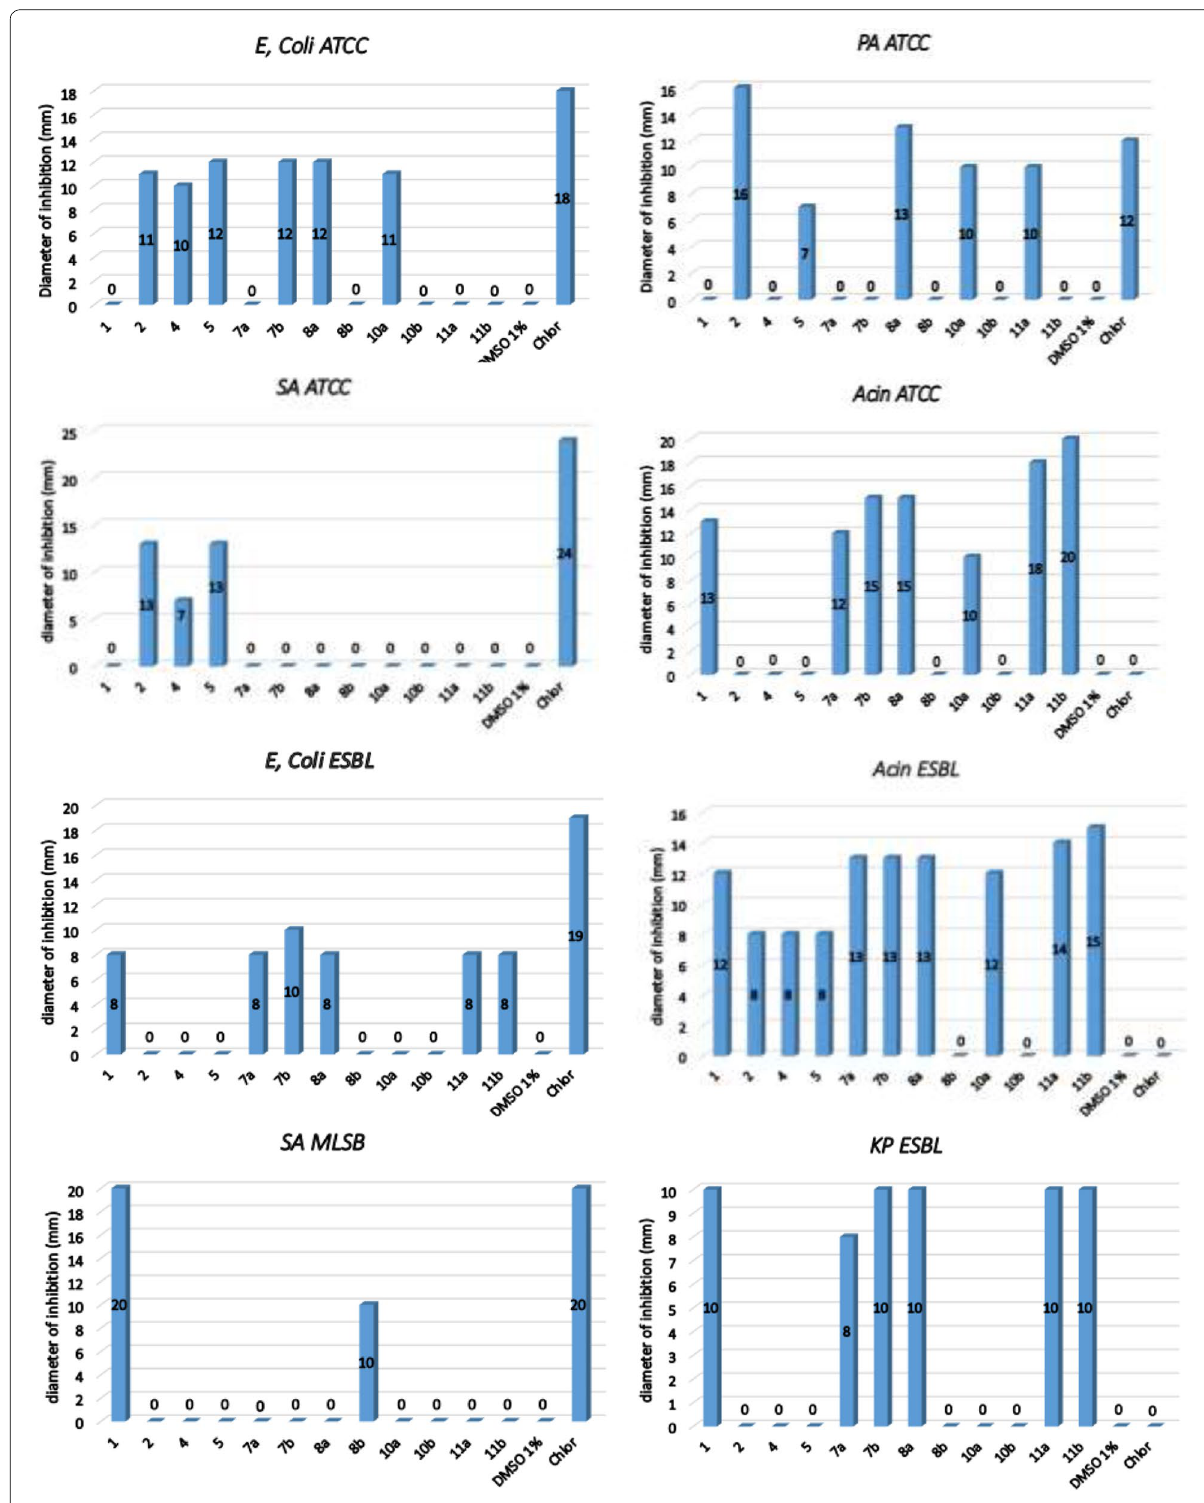
Fig. 5 Results of the antibacterial activity of the synthesized compounds 1 , 2 , 4 , 5 , 7a , 7b , 8a , 8b , 10a , 10b , 11a and 11b vis-a-vis bacteria tested ( Escherichia coli ATCC, Pseudomonas aeruginosa ATCC, Staphylococcus aureus ATCC, Acinetobacter ATCC, Escherichia coli BLSE, Acinetobacter BLSE, Staphylococcus aureus MLSB and Klebsiella pneumonia BLSE ). Chlor chloramphenicol (30 µg/ml), DMSO dimethylsulfoxide